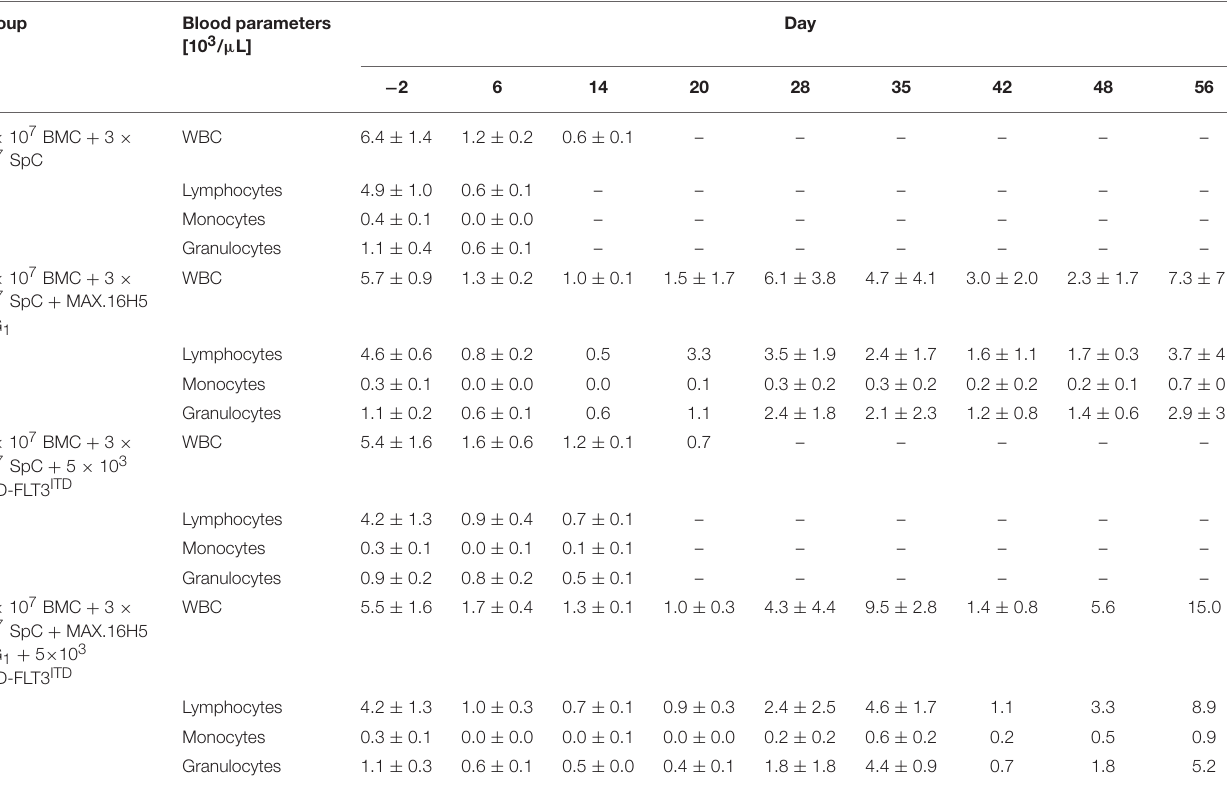
TABLE 1 | Blood sample analysis (WBCs, lymphocytes, monocytes, and granulocytes) of C3H/HeN mice after transplantation of 1 × 10 7 bone marrow cells (BMC) and 3 × 10 7 spleen cells (SpC) with or without MAX.16H5 IgG 1 pre-incubation in combination with or without 5 × 10 3 32D-FLT3 ITD cells at different time points.